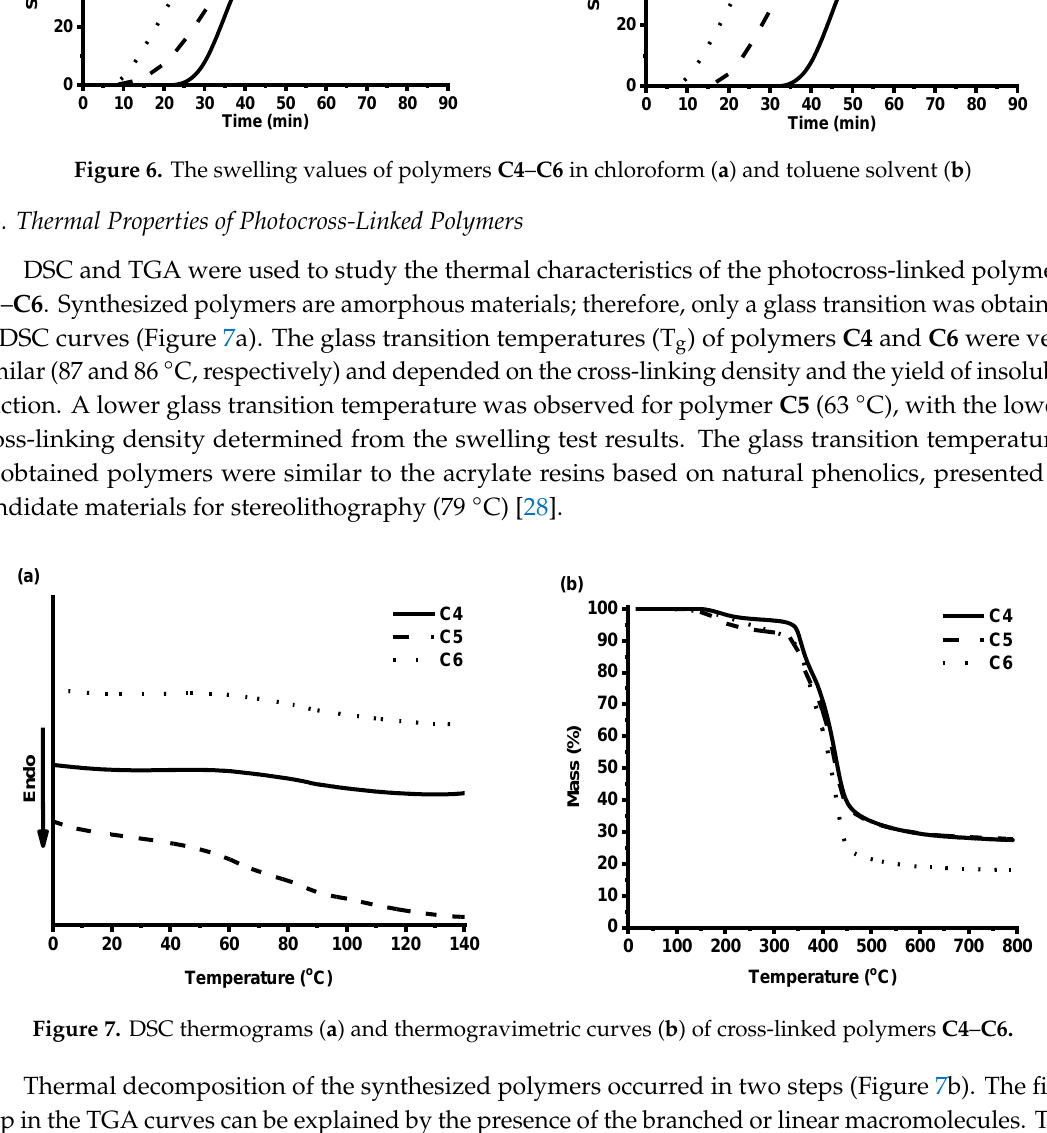
Figure 6. The swelling values of polymers C4 – C6 in chloroform ( a ) and toluene solvent ( b ) Table 3. Characteristics of the cross-linked vanillin-based polymers.